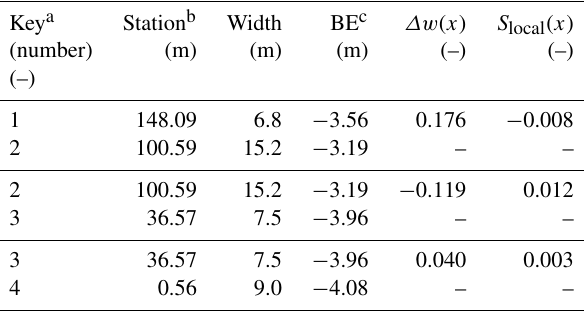
Table B3. Measurement details for Fig. 4 of Cao et al.